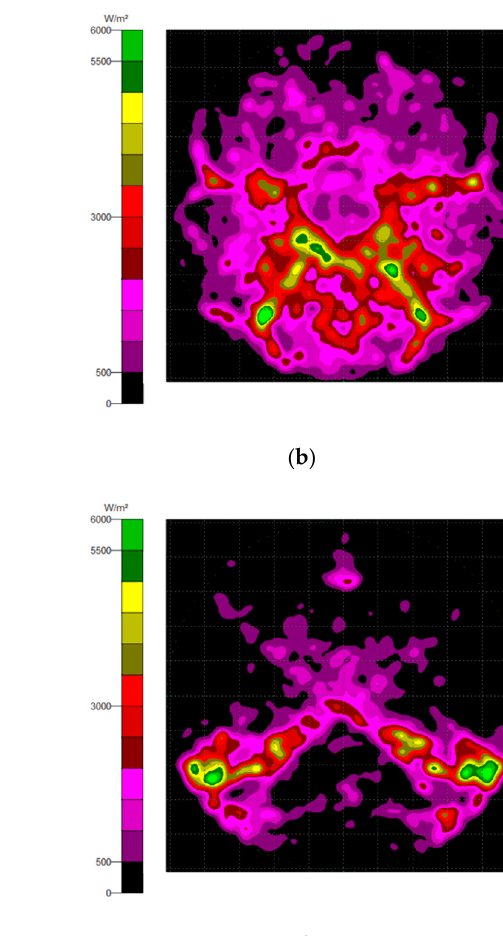
Figure 23. The irradiance distribution of the solid-NACPC and new elliptical collimator with misalignment angles of ( a ) 0°, ( b ) 10°, ( c ) 20°, and ( d ) 30°.